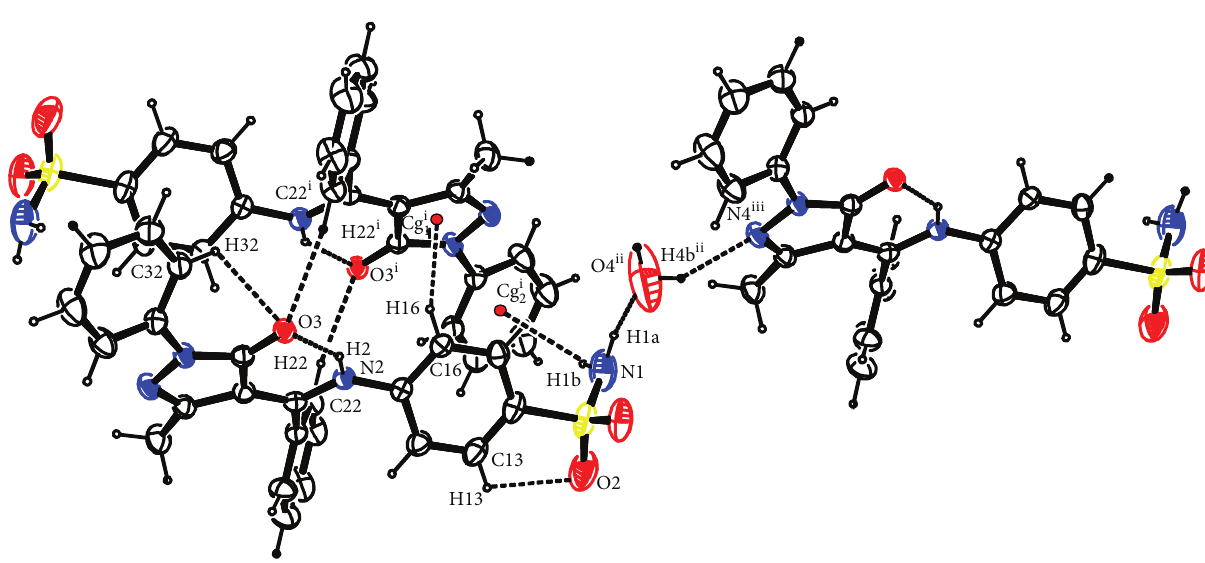
Figure 14: Hydrogen bonding in Bmpp-Sn ⋅ H 2